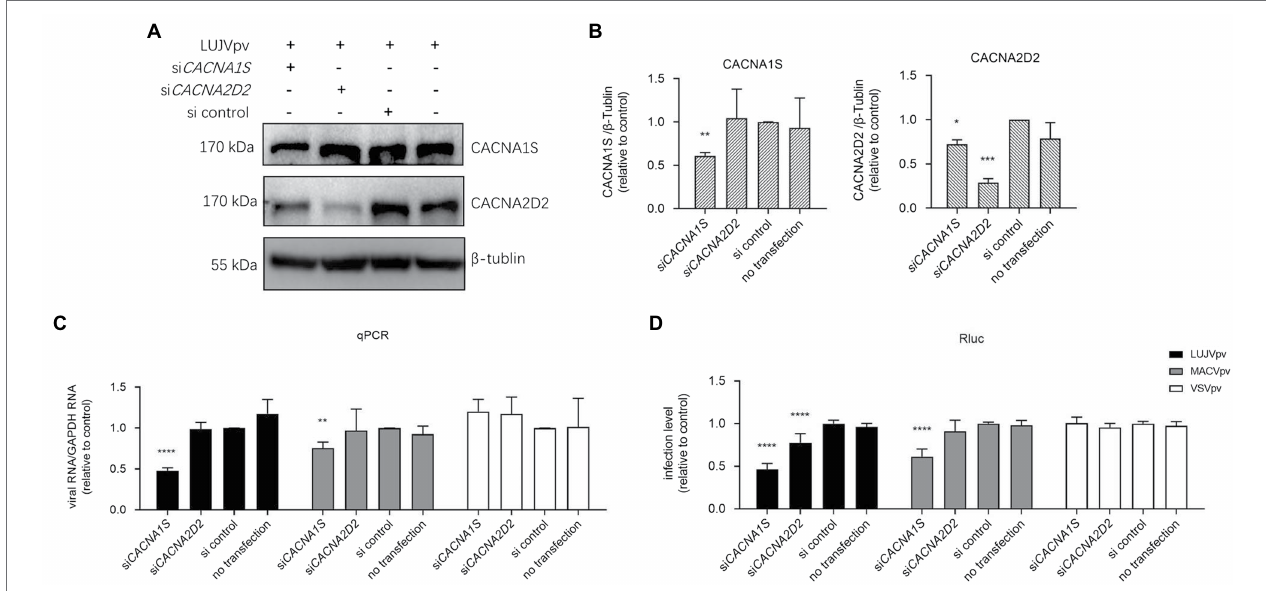
FIGURE 8 | Knockdown of voltage-gated calcium channel (VGCC) genes inhibited LUJVpv infection. (A) Western blotting (WB) assay of CACNA1S and CACNA2D2 in U-2 OS cells. U-2 OS cells were transfected with si CACNA1S and si CACNA2D2 , respectively. After 48 h, cells were infected with LUJVpv (MOI: 0.1) for 6 h. Then, the cell lysates were subjected to a WB assay. (B) Quantification results of WB assay. (C,D) Knockdown of VGCC genes inhibited LUJVpv infection. U-2 OS cells were transfected with si CACNA1S or si CACNA2D2 . After 48 h, cells were infected with LUJVpv (MOI: 0.1), MACVpv (MOI: 0.1), or VSVpv (MOI: 0.1). After 6 h, the duplicate cell lysates were subjected to qPCR (C) and Rluc assays (D) , respectively. Data are presented as presented as means ± SD from more than five independent experiments (**** p < 0.0001; *** p < 0.001; ** p < 0.01; and * p <